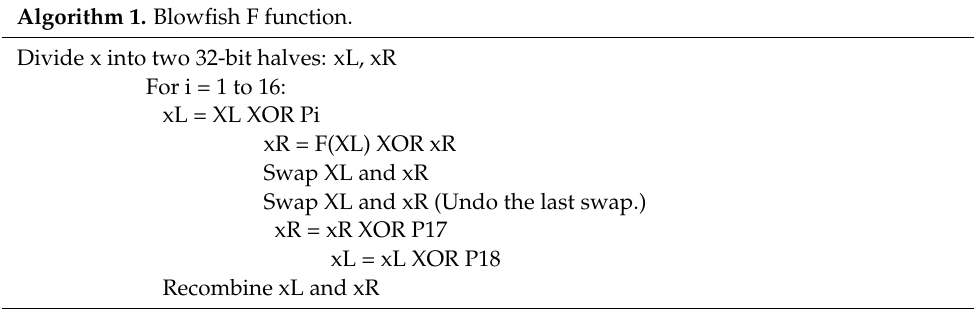
Algorithm 1. Blowfish F